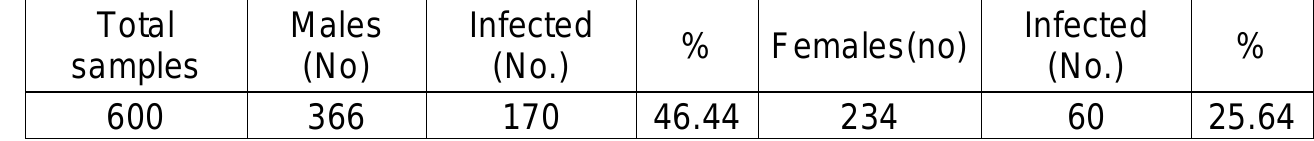
Table(2) : Rates of infection of E. histolytica (cyct) according to sexes. Total samples